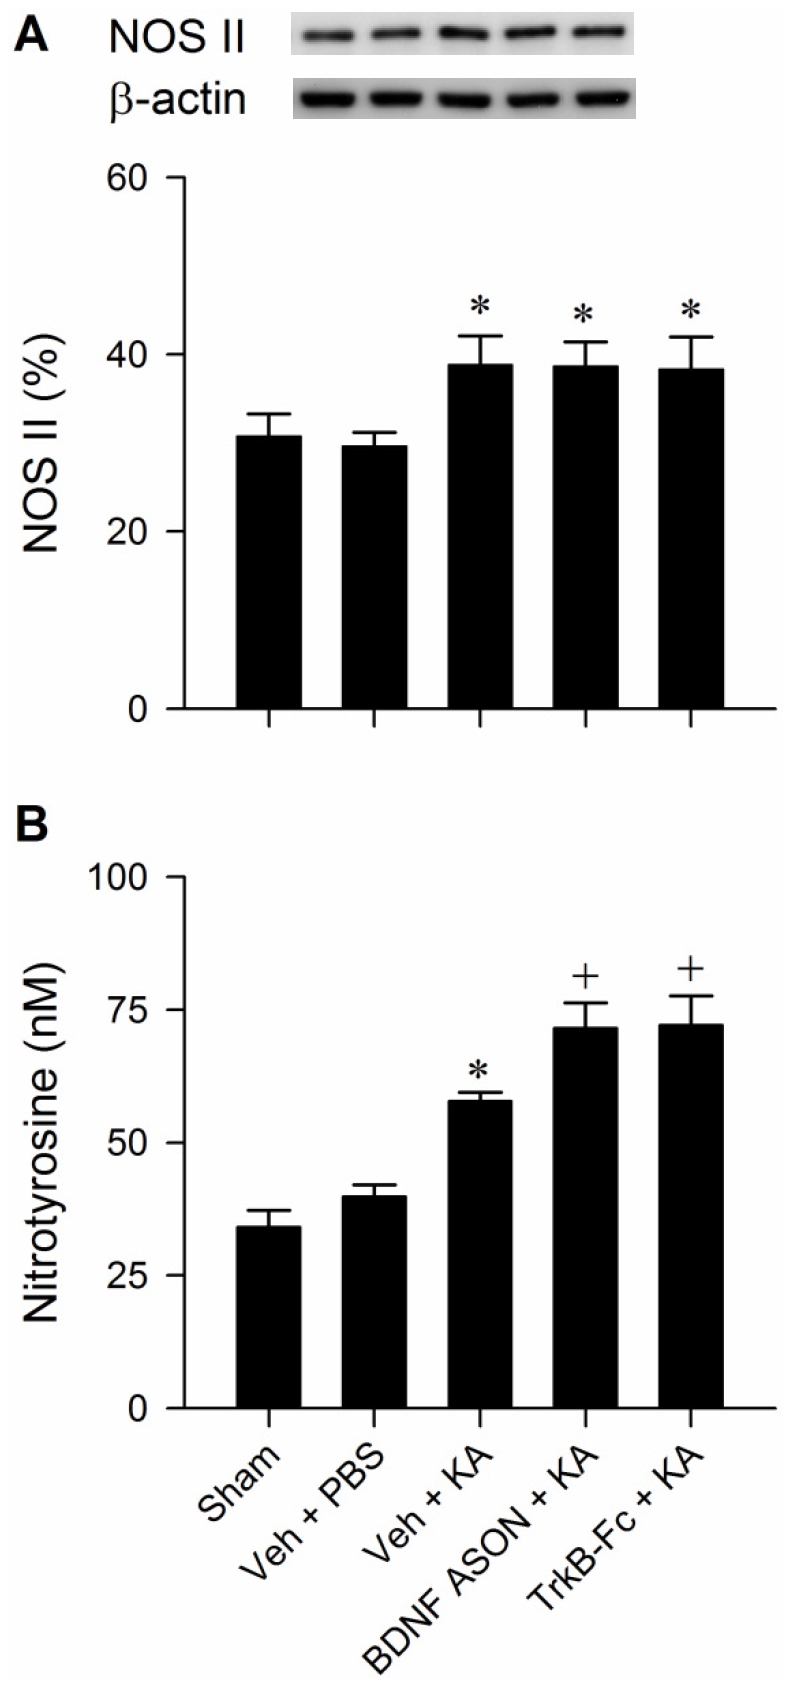
BDNF and TrkB reduce the upregulated peroxynitrite levels in RVLM during experimental TLSE.Illustrative gels or summary of changes in NOS II detected by Western blot analysis (A) or nitrotyrosine (experimental index for peroxynitrite) detected by ELISA (B) in samples collected from bilateral RVLM of sham-control or 180 min after microinjection of KA (0.5 nmol) or PBS into the left hippocampal CA3 subfield of animals that received pretreatment by application into the bilateral RVLM of distilled water or 0.1 M PBS (Veh), BDNF ASON (100 pmol) or TrkB-Fc (1.5 pmol). Values are mean ± SEM of triplicate analyses on individual samples obtained from 5–6 animals per experimental group. *P<0.05 versus sham-control or Veh+PBS group, and +
P<0.05 versus Veh+KA group in the post hoc Scheffé multiple-range test.